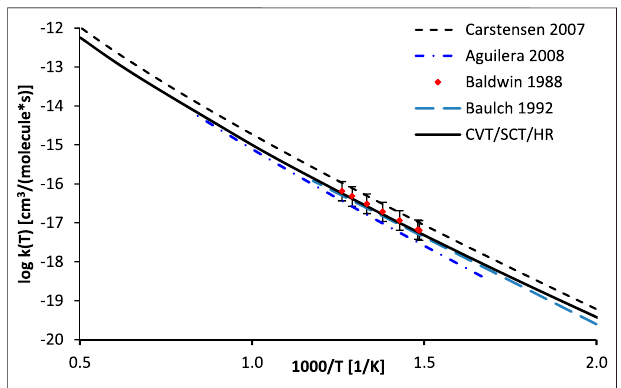
FIGURE 4 | Arrhenius plot of the calculated rate constants for the reaction R 1 (C 2 H 6 + · OOH → · C 2 H 5 + H 2 O 2 ) along with literature